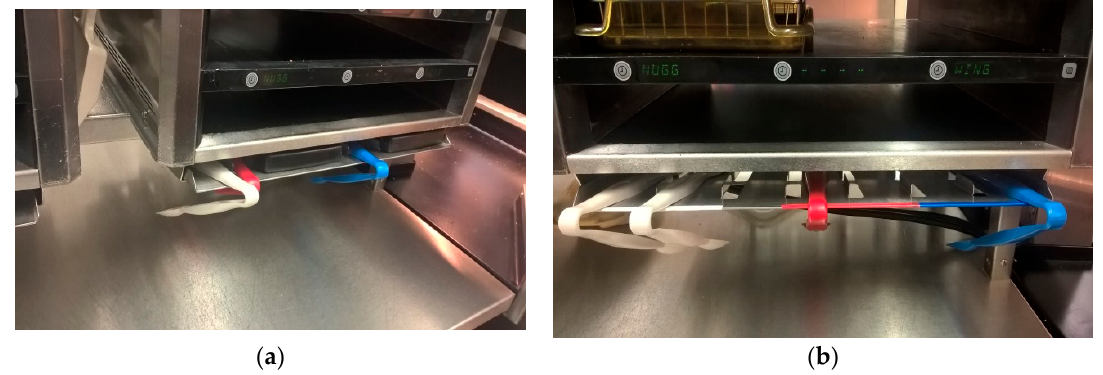
Figure 6. The system of tongs: ( a ) before applying 5S; ( b ) after applying 5S.